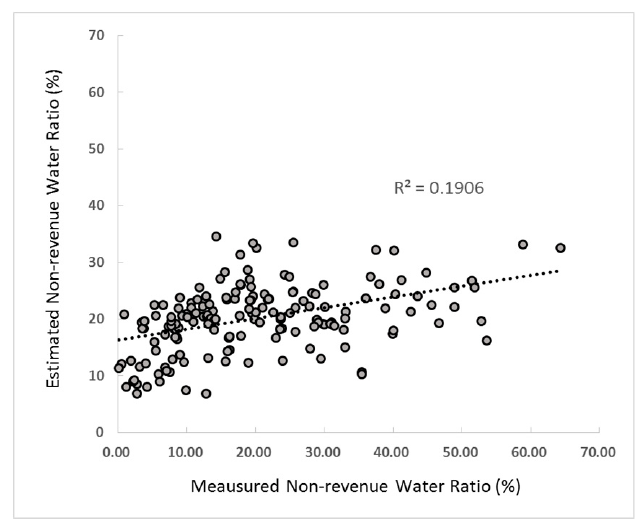
Figure 12. Scatter Plot of NRW Ratio Using Nonlinear MRA Results.